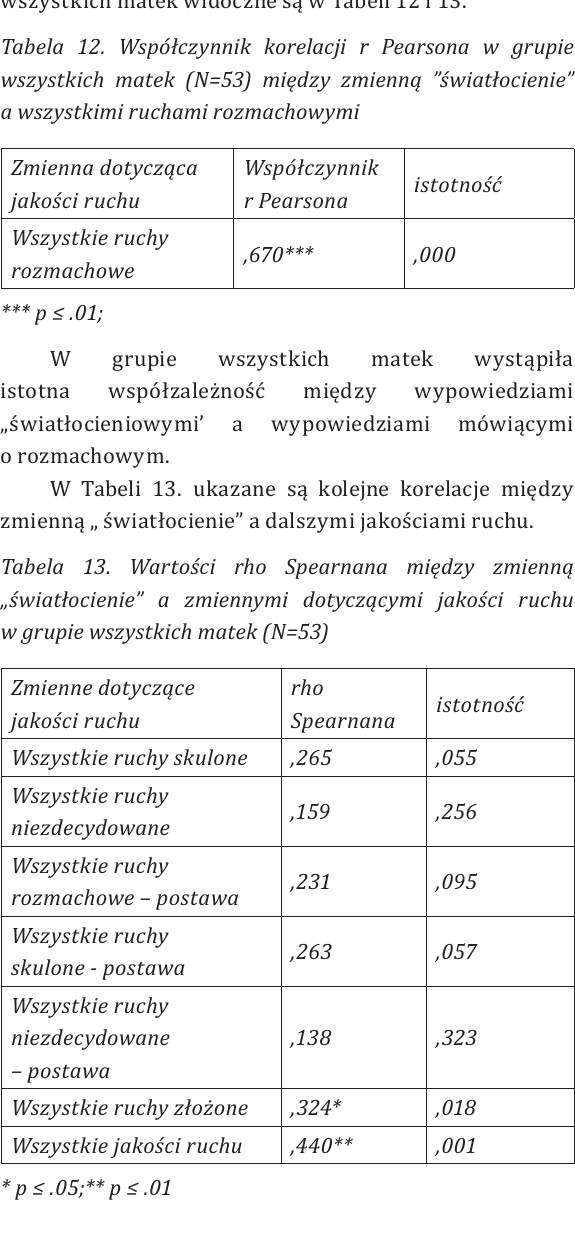
Tabela 12. Współczynnik korelacji r Pearsona w grupie